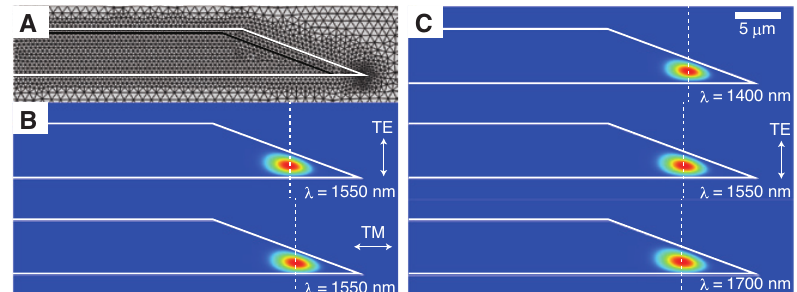
Figure 4: Examples of mode profile simulation with FEM. (A) Created mesh cells for axisymmetric microdisk resonator with 40 ° wedge angle in FEM calculation. (B) Calculated mode profile of fundamental TE and TM modes around 1550 nm. The TM mode slightly extends the outer boundary of the disk resonator. (C) Comparison of mode profiles at three different wavelengths. At longer wavelengths, the center of the optical mode is shifted inside the